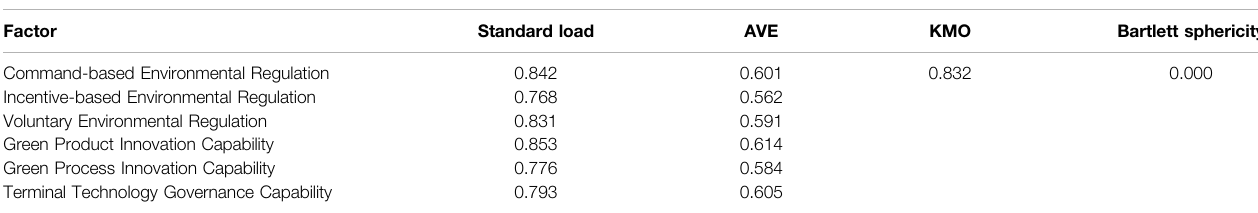
TABLE 3 | Factor analysis